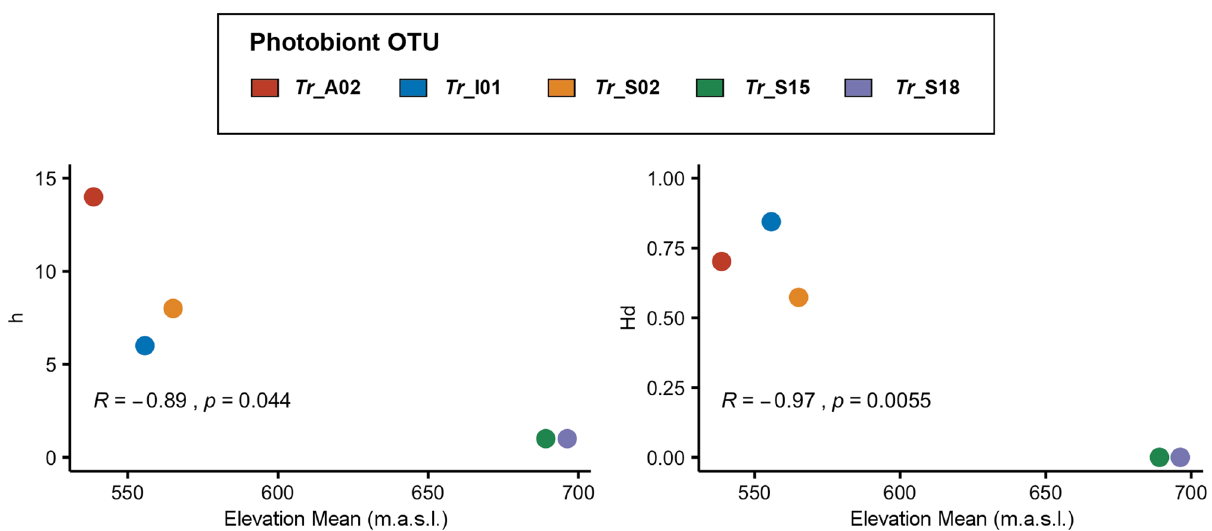
Figure 5. Correlation plots. Diversity indices h (number of haplotypes) and Hd (haplotype diversity) against mean elevation of sample sites for photobiont OTUs with n ≥